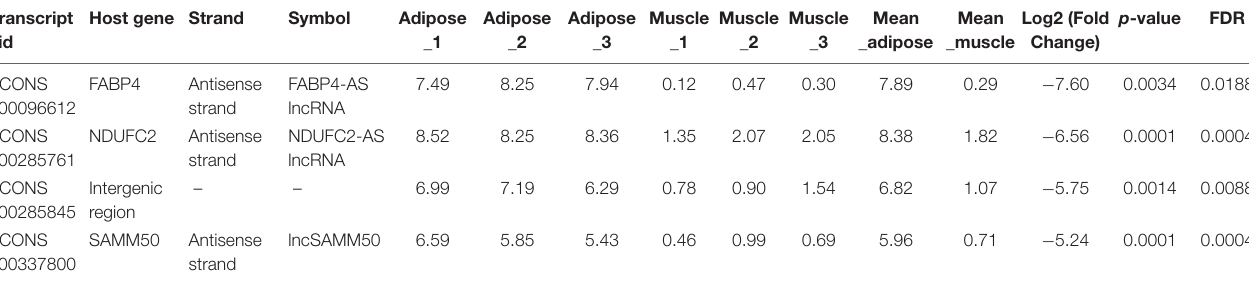
FIGURE 1 | Validation of differentially expressed (DE) lncRNAs by qRT-PCR. (A) Expression patterns of the 13 DE lncRNAs in the adipose and muscle tissues of buffalo based on RNA sequencing. The expression level of lncRNA is indicated as log2(FPKM+1). Data are presented as mean ± SD ( n = 3; * p < 0.05; ** p < 0.01). (B) Expression patterns of the 13 DE lncRNAs in the adipose and muscle tissues of buffalo analyzed by qRT-PCR. The RNA expression levels are normalized to those of UXT . Data are presented as mean ± SD ( n = 6; * p < 0.05; ** p < 0.01). TABLE 1 | Candidate lncRNAs associated with fat deposition in